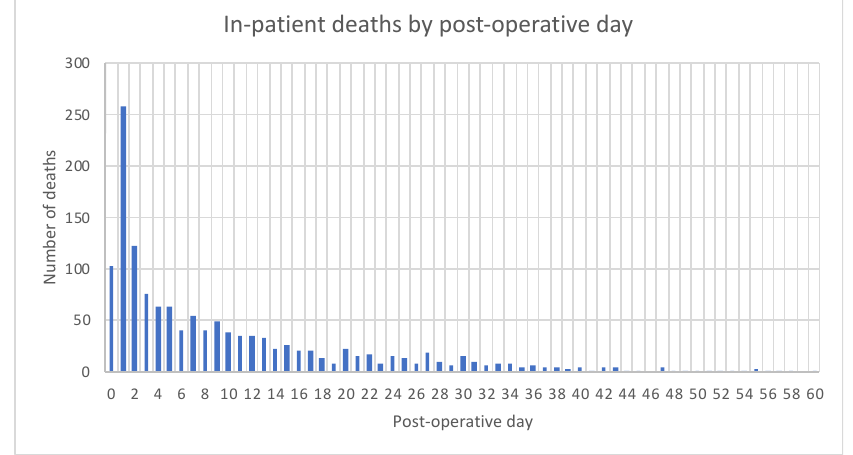
Figure 1. Number of patients that died on days following emergency laparotomy surgery. J. Clin. Med. 2020 , 9 , x